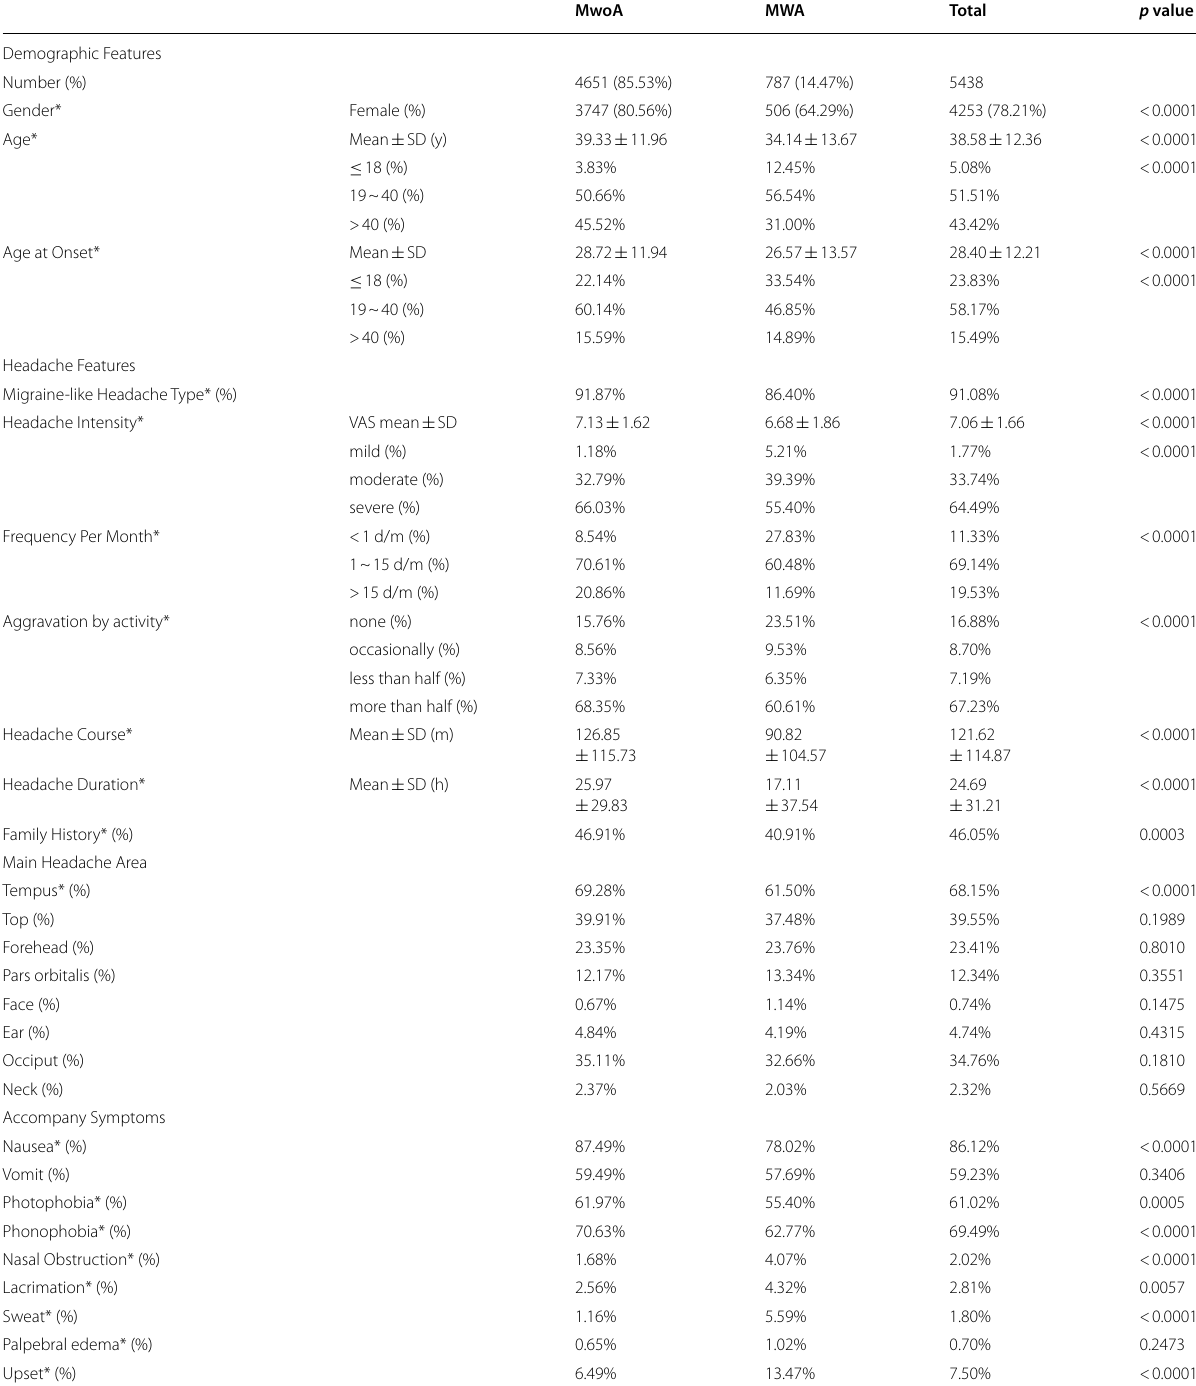
Table 1 Basic features of demography and